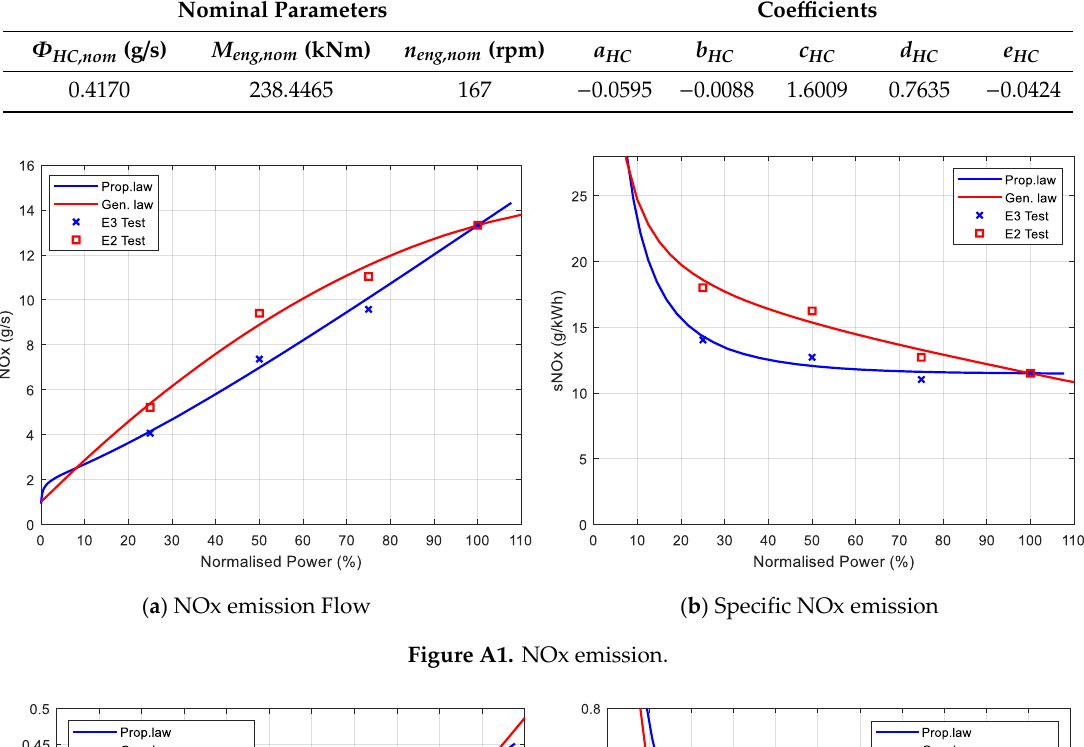
Table A4. Coefficients of NOx emission model of auxiliary engine. Nominal Parameters